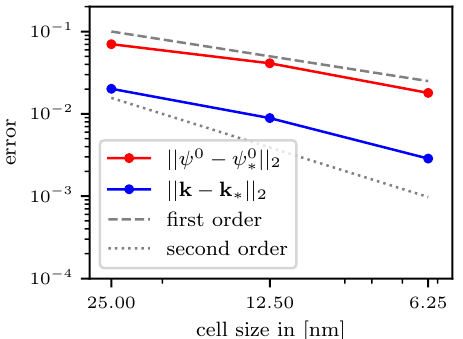
Figure 4. Error of the solution of the M 1 -model ψ 0 and the k-ratios k compared to a reference solution calculated with high resolution ψ 0 ∗ and k ∗ . The cell size of the reference solution is 3.125 nm, and the energy interval is discretized in 350 steps. For reference, the gray dashed and dotted lines indicate the first and second order.